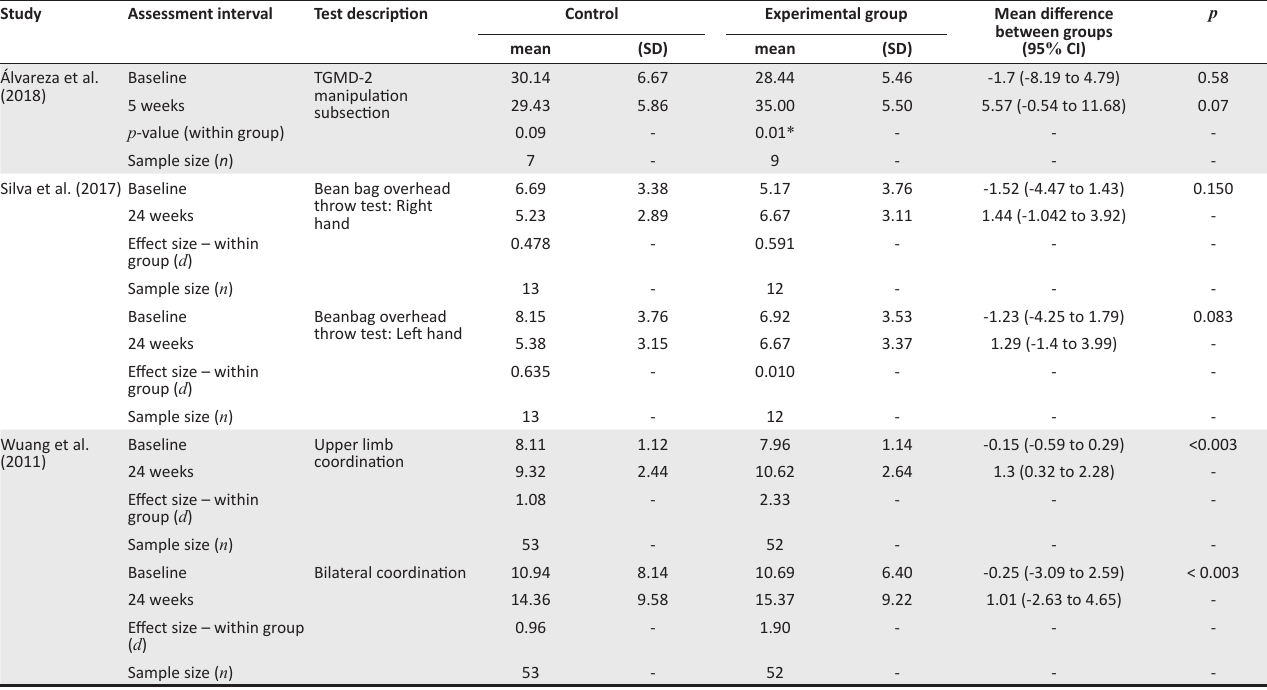
TABLE 7 : Results reported for coordination measures of included